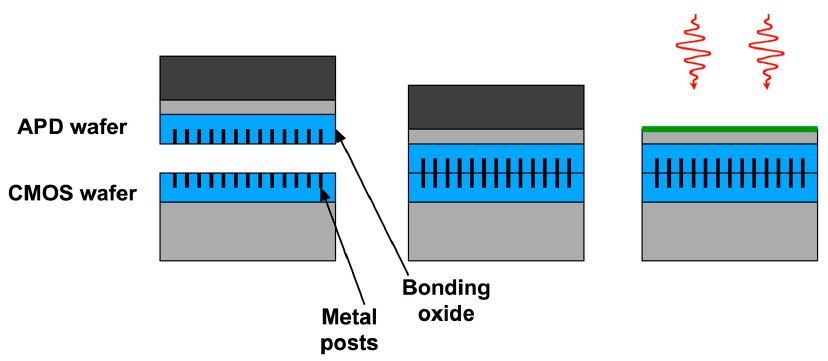
Figure 6. Via-first 3D integration.